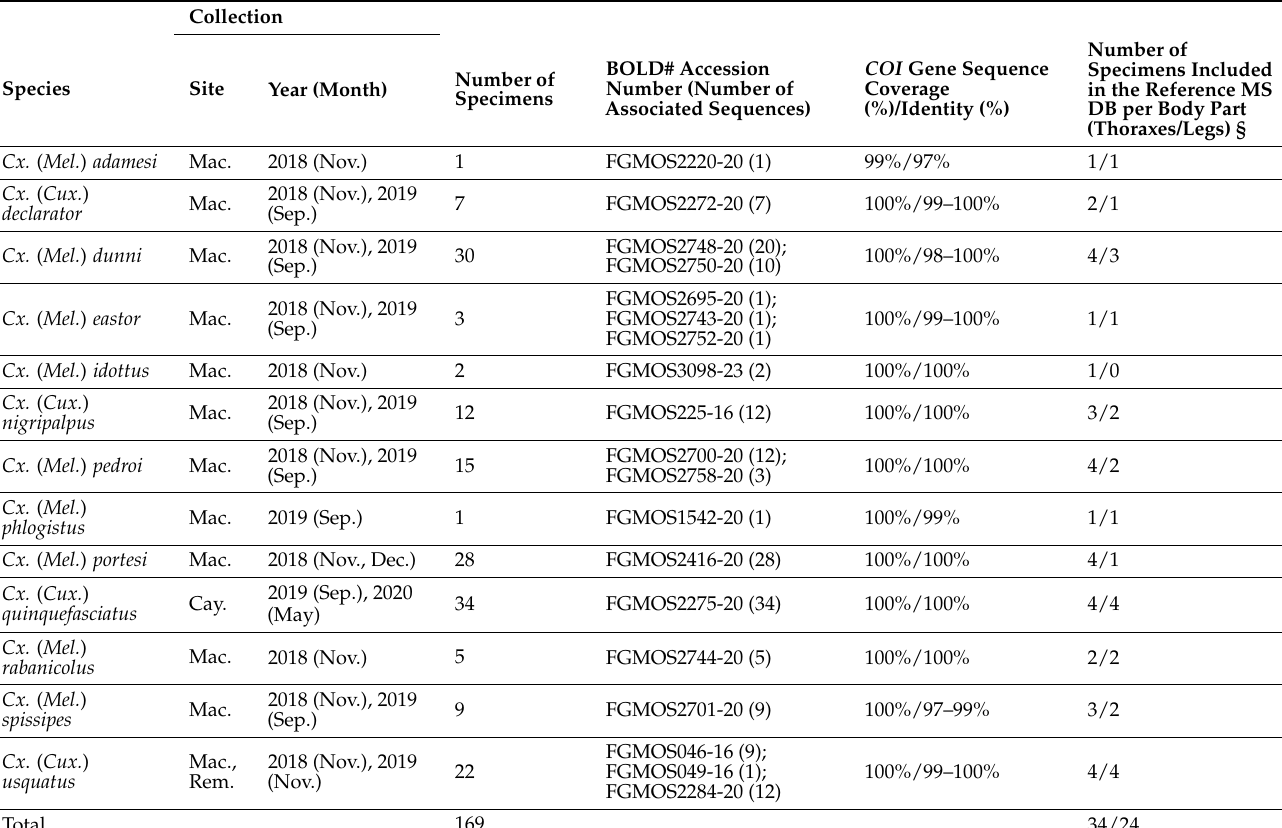
Table 1. Overview of Culex mosquito origins and identification by COI molecular